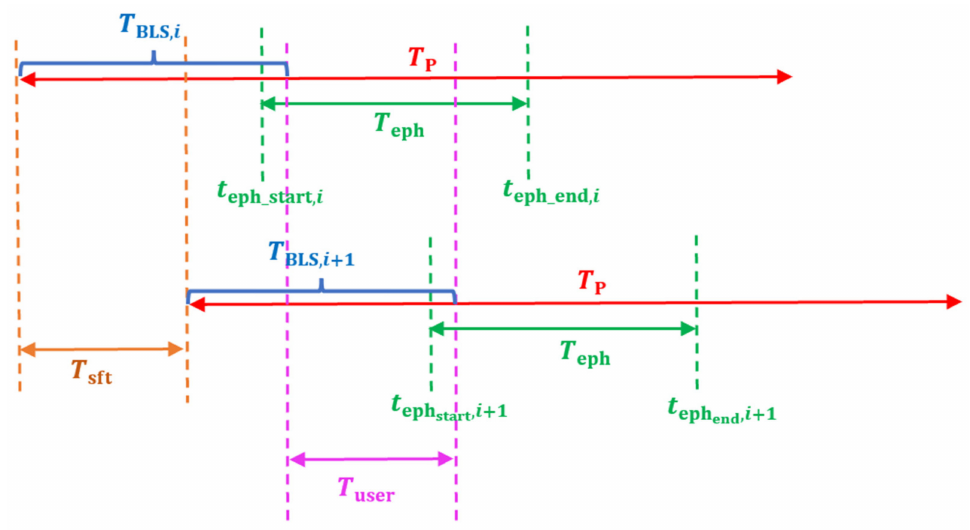
Figure 2. Time scheme for real-time LEO satellite POD based on the near-real-time BLS adjustment, the short-term prediction, and the ephemeris fitting.